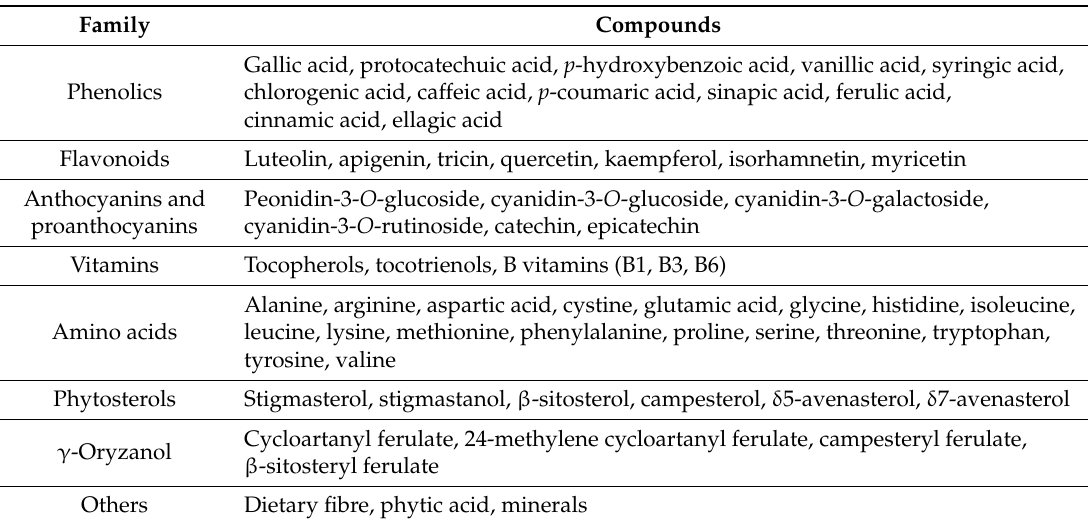
Table 1. Summary of the major phytochemical composition of brown